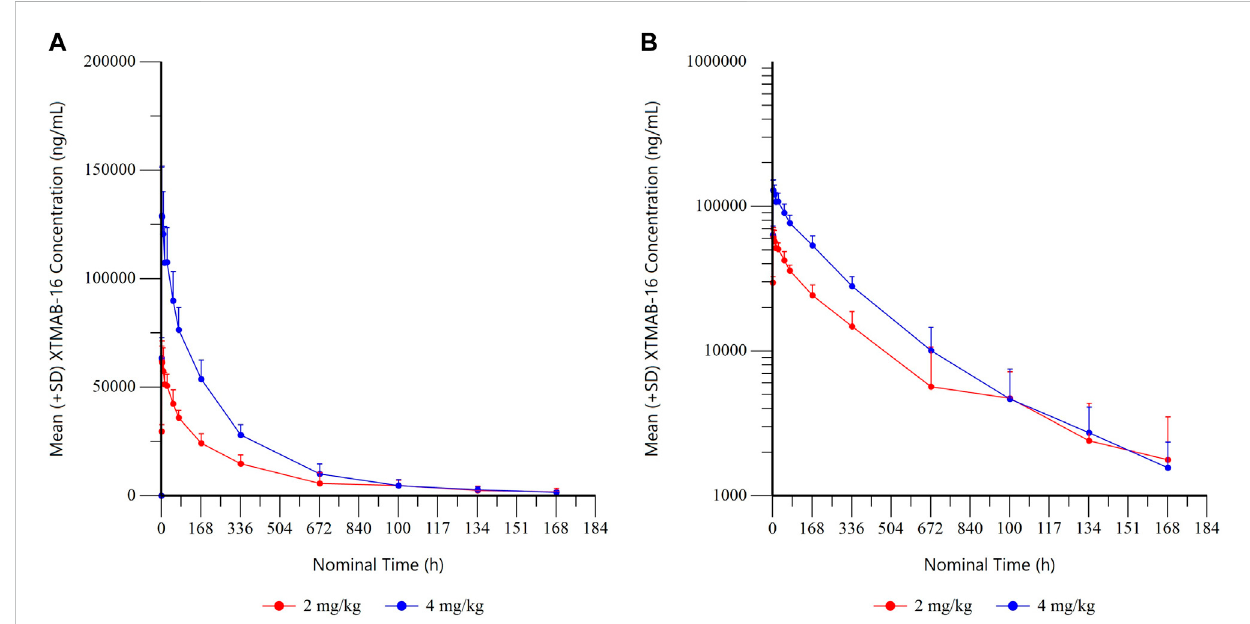
FIGURE 4A Summary XTMAB-16 Concentration Versus Time by Dose. (A) linear, (B) semi-log. Note: All BLQ samples after T max were set to missing for calculation of summary statistics. Abbreviations: BLQ = below thelimit of quantitation; SD = standard deviation; T max = time to maximum